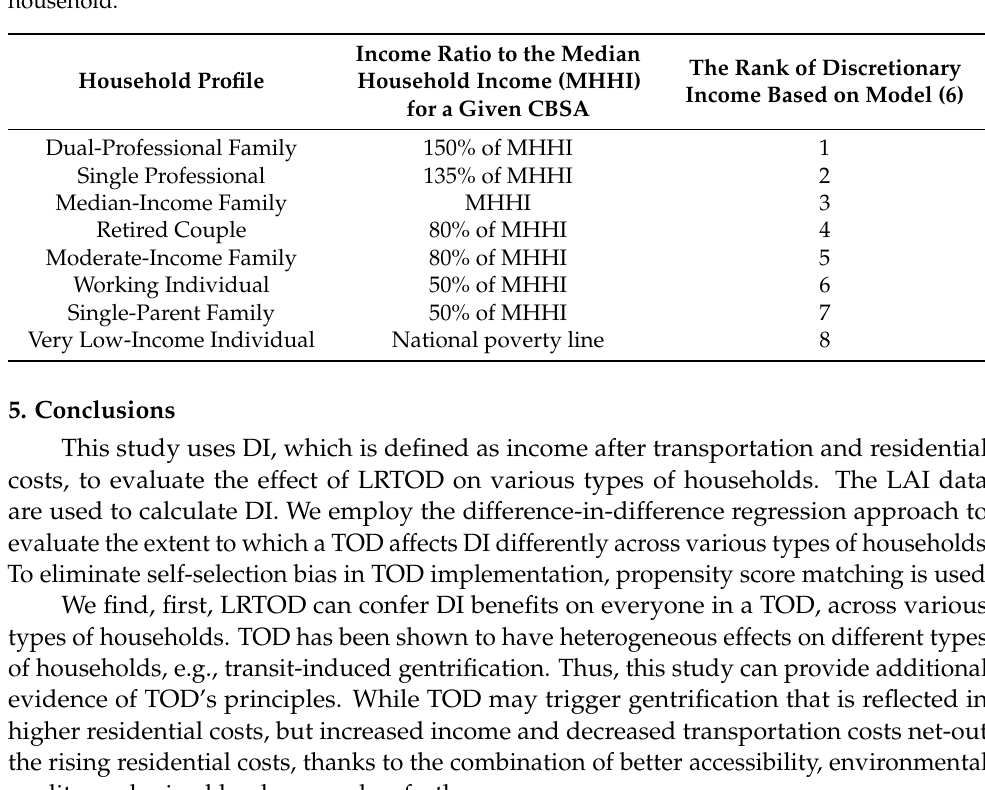
Table 5. Comparing rank between discretionary income (DI) and household income across types of